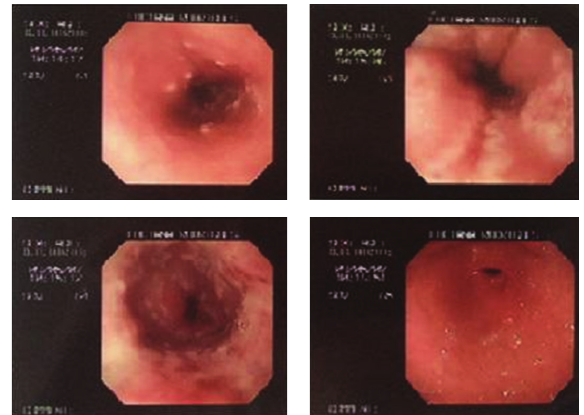
Figure 1: Upper digestive endoscopy showing numerous injuries on the esophageal surface that were yellow-whitish in color, pleo- morphic, and isolated small circular plaques with central erosions and even depression with hyperemia at baseline; these injuries were more prominent in the distal third of the esophagus, indicating infectious esophagitis.